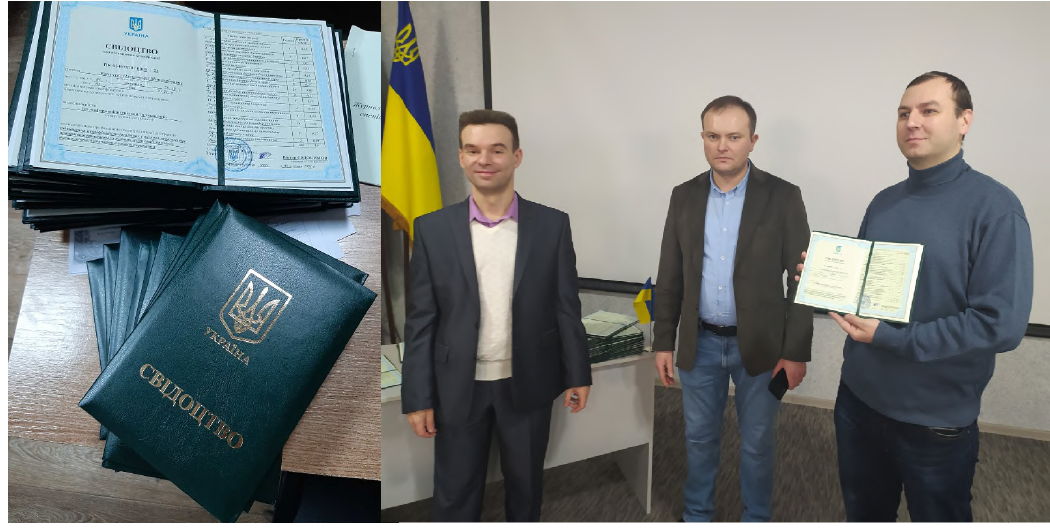
Figure 33: Presentation of paper